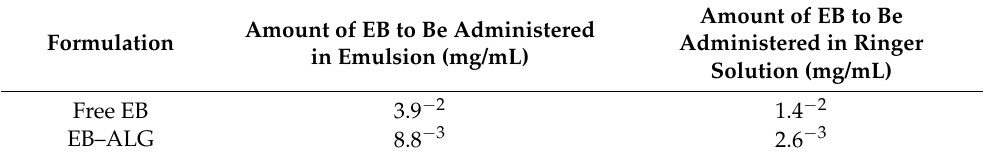
Table 5. Amount of EB in formulations to reach the therapeutic dose against C. rogercresseyi . Amount of EB to Be Amount of EB to Be Administered Formulation Administered in Ringer in Emulsion (mg/mL) Solution (mg/mL) Free EB 3.9 − 2 1.4 − 2 EB–ALG 8.8 − 3 2.6 −